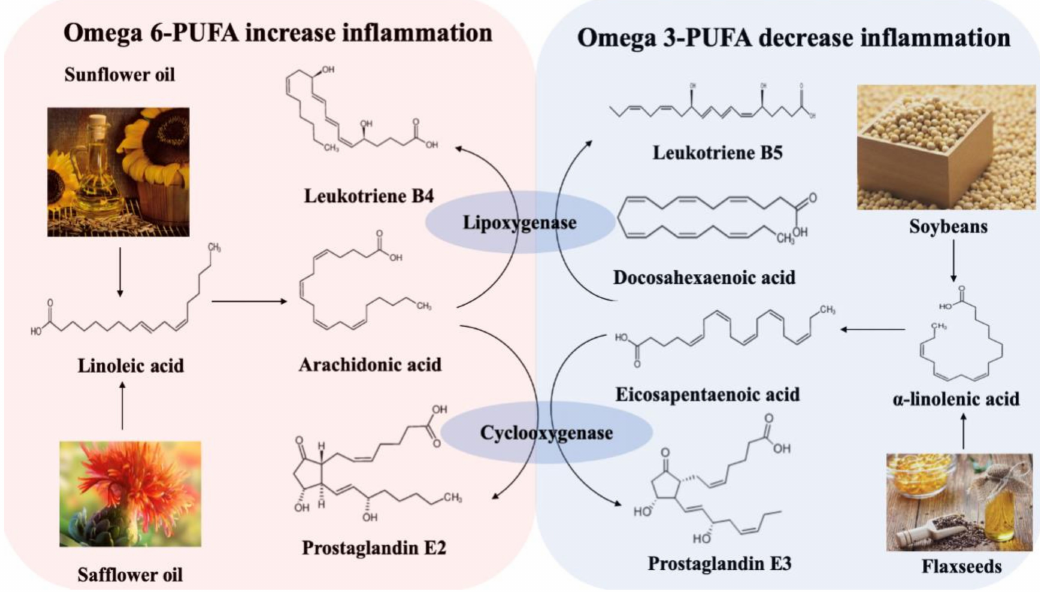
Figure 2. Metabolism of omega-6 and omega-3 polyunsaturated fatty acids